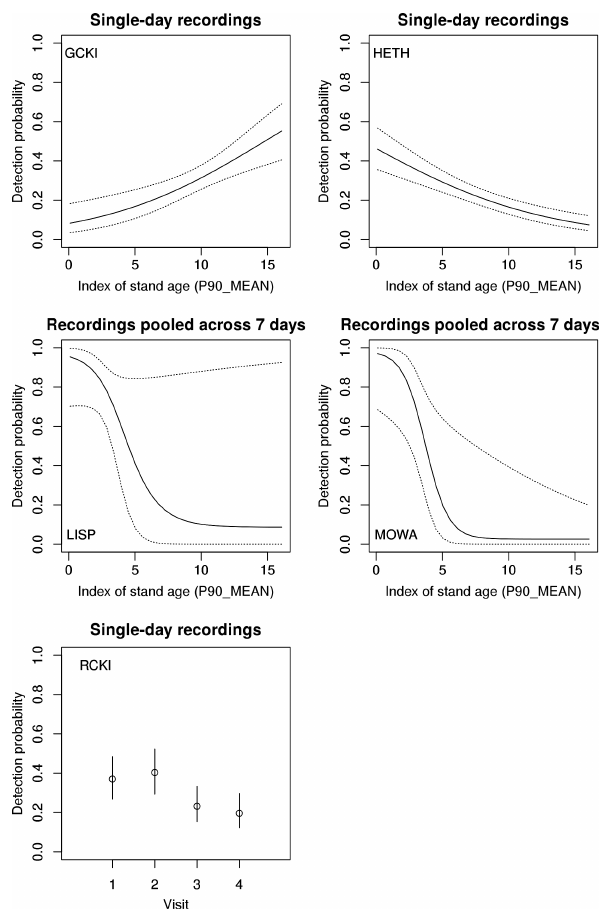
Fig. 3 . Effect of stand characteristics on detection probability of forest birds based on 10-min recordings collected with automated recording units in 2013 and 2014 at 109 stations in Hearst Forest Sustainable Forest License, Ontario, Canada. See Table 4 for species codes.